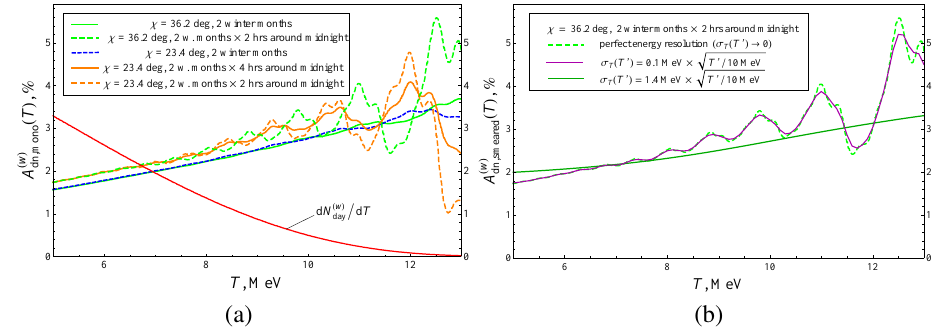
Figure 2. (a) The ‘experimental’ asymmetry (6) versus the electron recoil energy T depending on the observation time window and the latitude χ of the detector. The solid red curve shows the recoil energy distribution of the neutrino events in arbitrary units. (b) The same but smeared over a finite recoil energy resolution of the